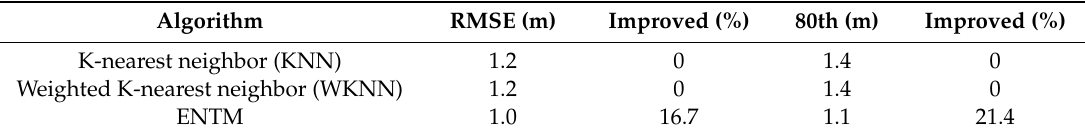
Table 2. Locating error